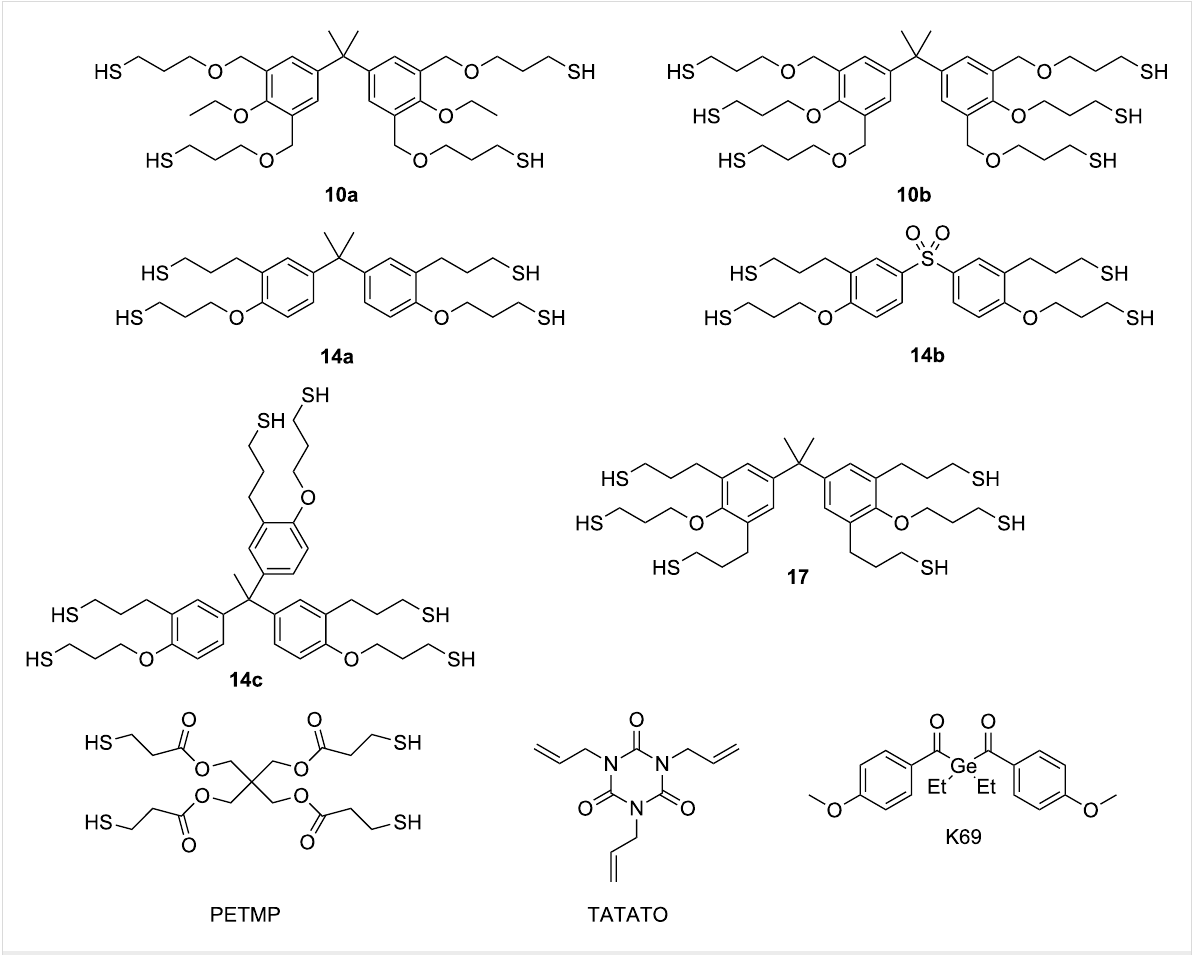
Scheme 3: Chemical structures of components utilized in the present study.